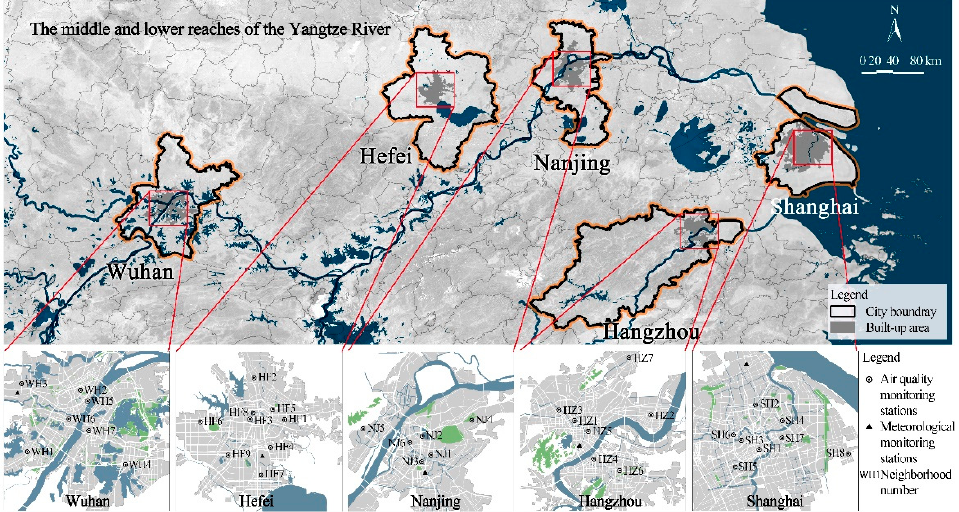
Figure 1. Location of five megacities and distribution of monitoring stations [32].